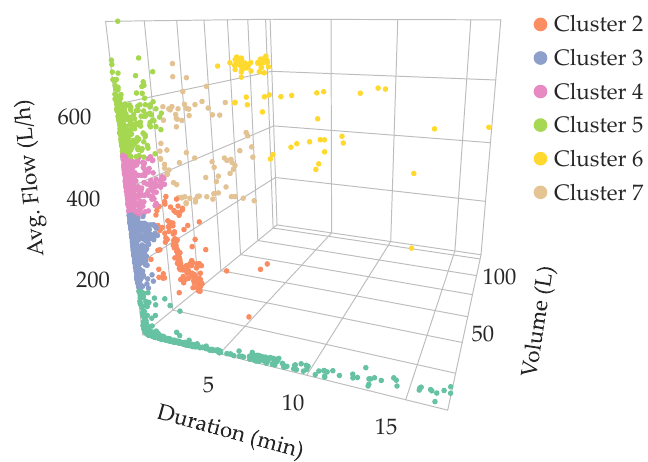
Figure 6. Result of Partition Around Mediods (PAM) algorithm with a number of clusters equal to 7 and similarity matrix based on Gower distance.